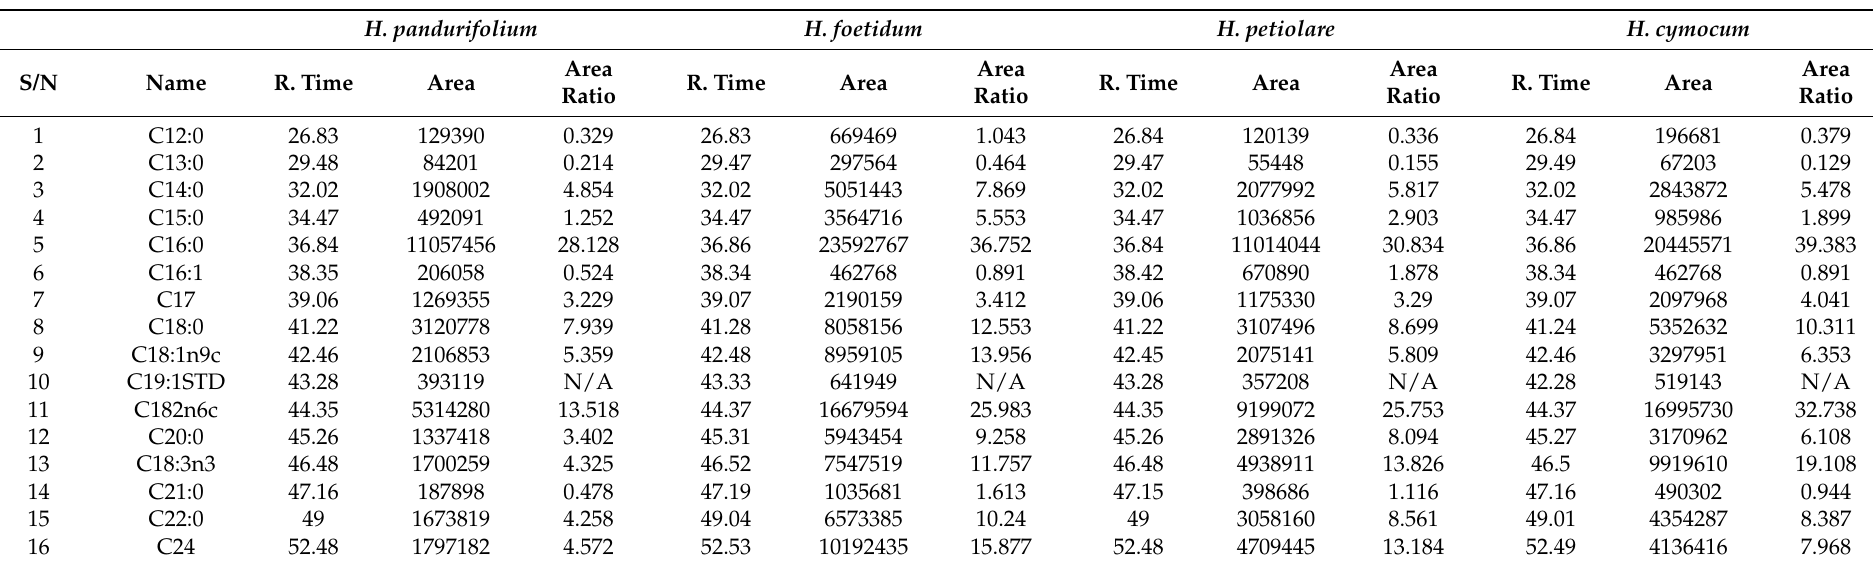
Table 6. Shows fatty acids, area of the peaks, ratio area, and the retention time (R, time) obtained from gas chromatography-mass spectrometry (GC- MS) analysis of the aqueous acetone extract of H. pandurifolium, H. foetidum H. petiolare, and H. cymocum